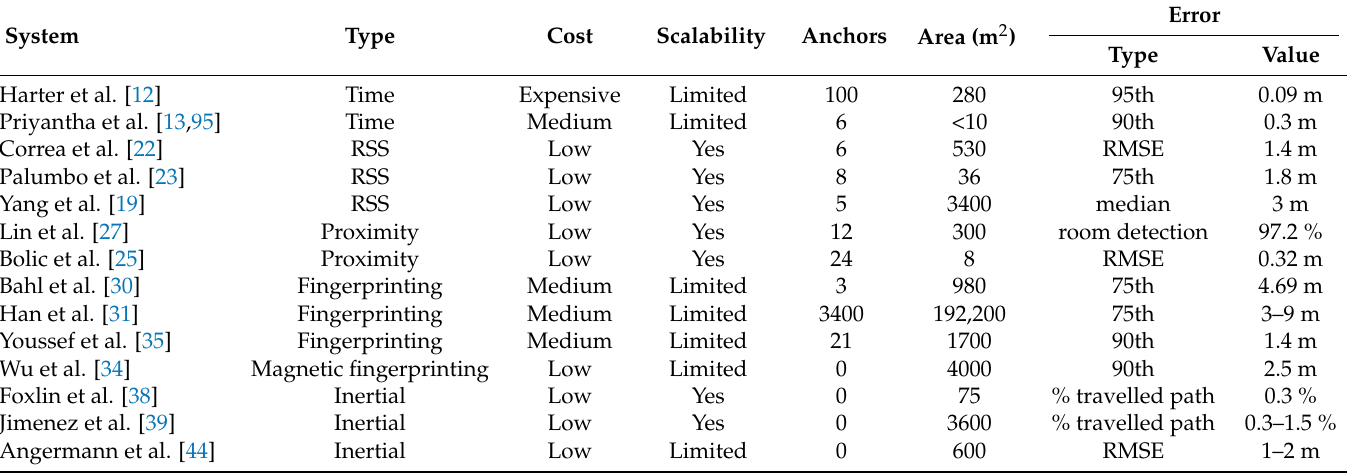
Table 1. Overview of Indoor Positioning